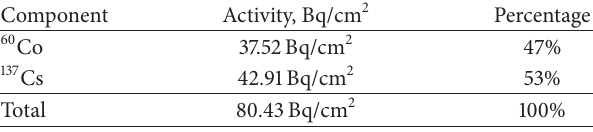
Table 2: Source term for ECCS vessel bottom part